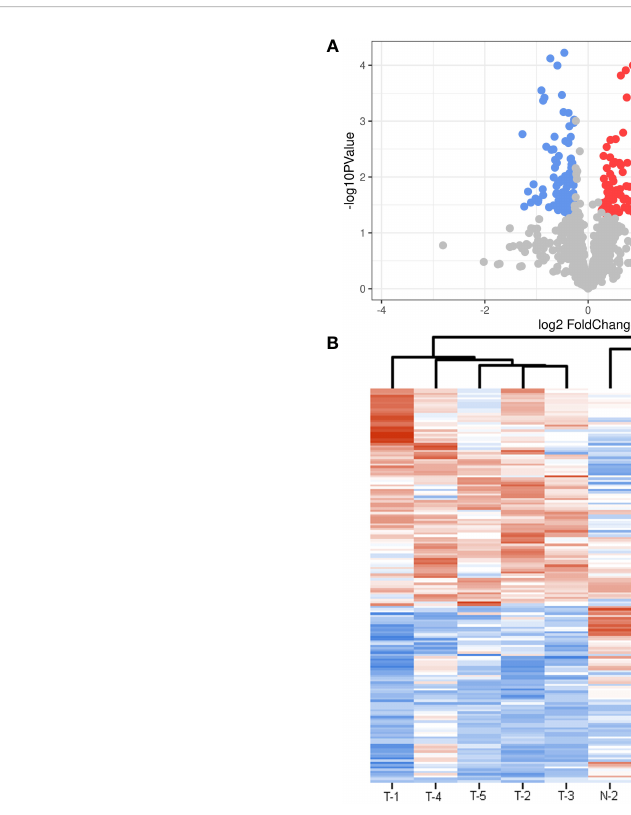
FIGURE 5 Screen of different expressed proteins (DEPs) between the plasma-derived exosomes from thin and normal Bactrian camels. (A) The volcano fi gure of DEPs. (B) The heatmap of these screened DEPs in the different